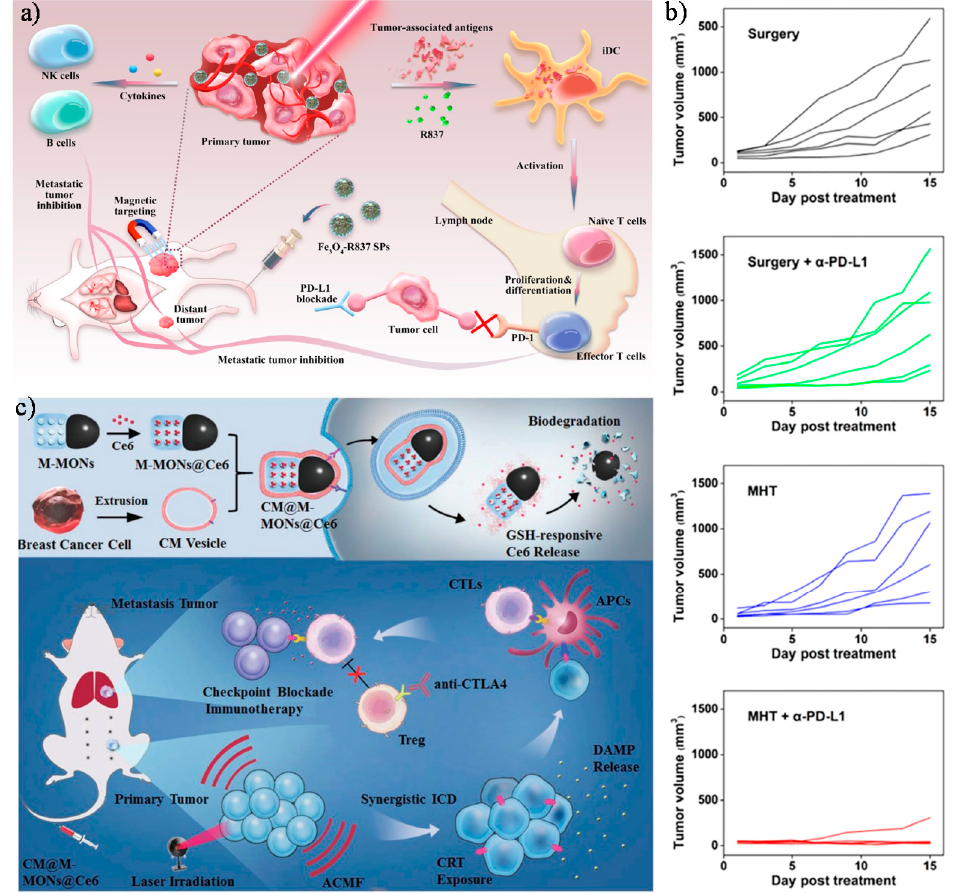
Figure 8. ( a ) Schematic demonstration of the synergistic anti-tumour effects of checkpoint blockade immunotherapy in combination with photothermal/R837-based therapy for promoting innate and adaptive anti-tumour responses. ( b ) Individual growth curves of mice divided into four treatment groups: surgery, surgery + α -PD-L1, MHT, and MHT + α -PD-L1. ( c ) Schematic representations of Janus magnetic mesoporous organosilica nanoparticles loaded with chlorine c6 and coated by cancer cell membrane for tumour targeted combined cancer therapy (top). Magnetic hyperthermia and PDT synergize in triggering ICD in cancer cells, by inducing the release/exposure of DAMPs and TAAs, responsible for the activation of APCs. Once activated, APCs prime effector CD8 + cytotoxic T cell responses. Co-administration of anti-CTLA4 antibody can avoid T-cells anergy induction for an enhanced anti-tumour immune response that can inhibit primary tumour growth and prevent lung tumour metastasis (bottom). Reproduced with permission from References [140,141,143] (Copyright Wiley-VCH). 2018 and 2020 American Chemical Society and Copyright 2019